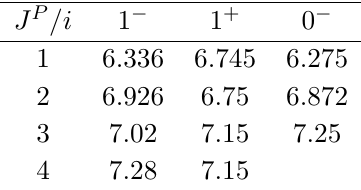
(in GeV) of the ¯ bc resonances P Table 1 . Mass M P i a 0 0 . 058 ± 0 . 002 h T 1